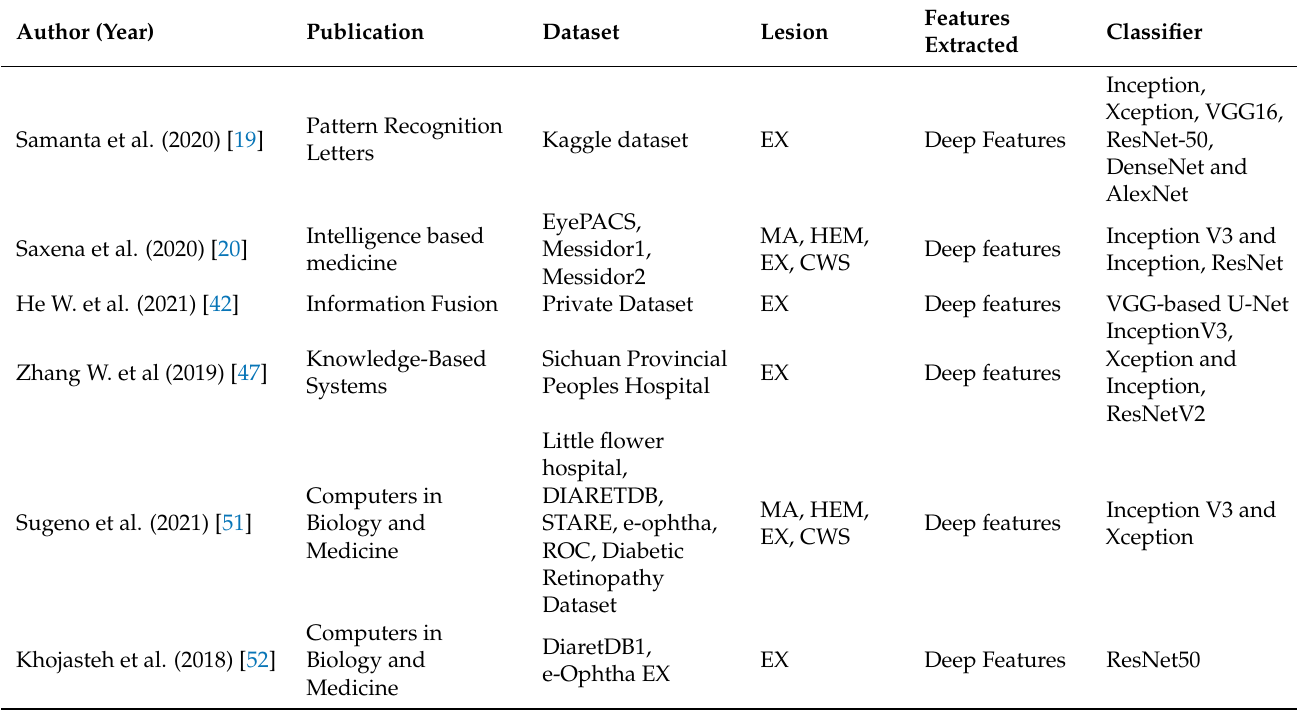
Table 11. Transfer learning styles used in the